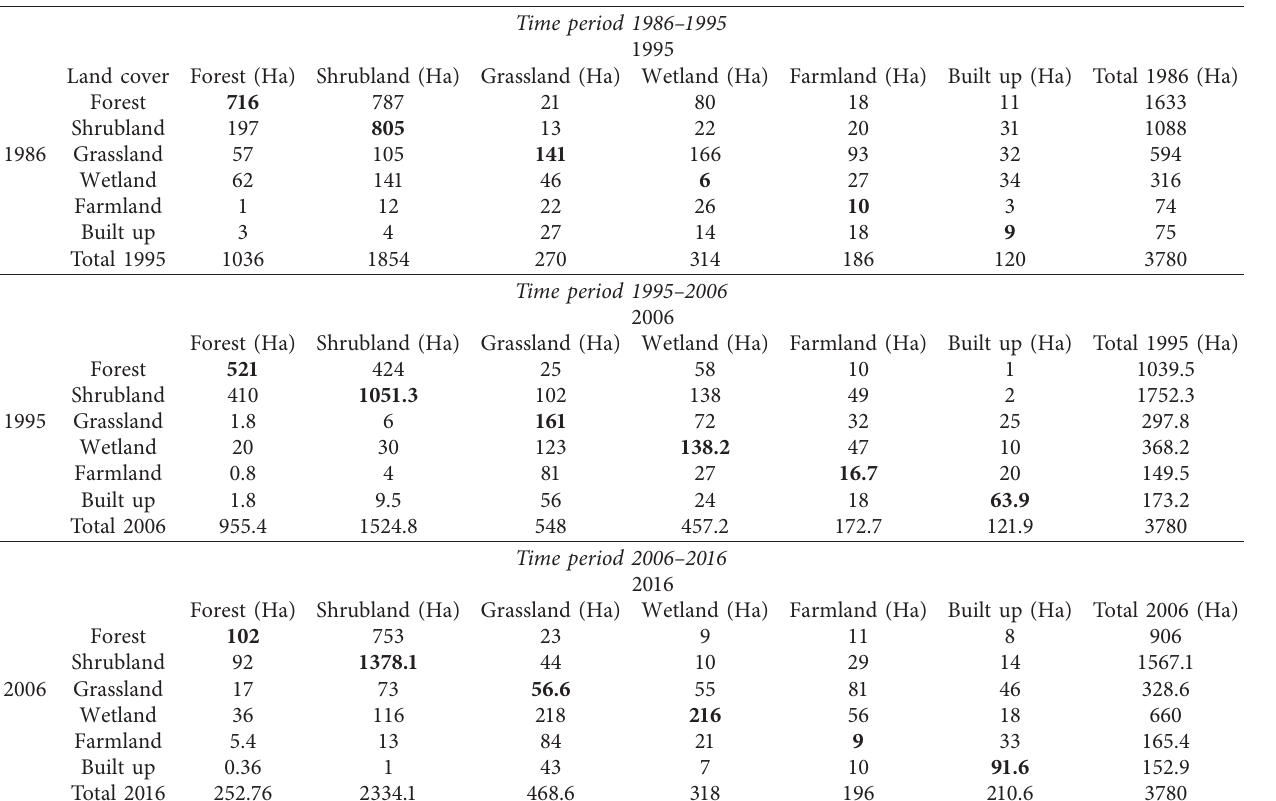
Table 6: Transition matrices for the periods 1986–1995, 1995–2006, and 2006–2016 in